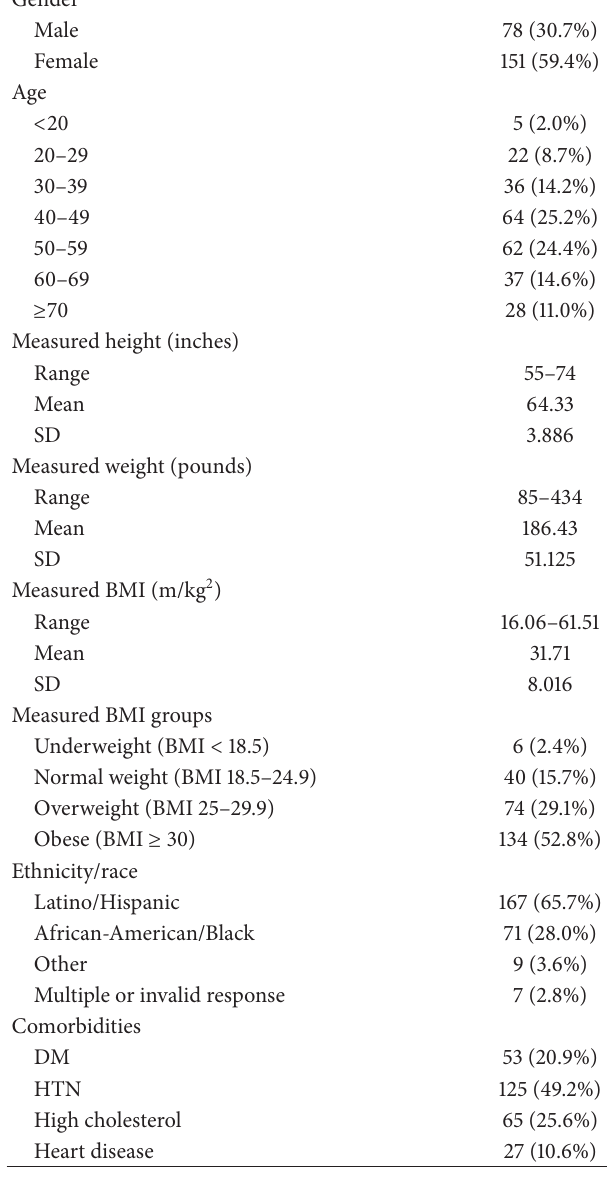
Table 1: Demographics of survey